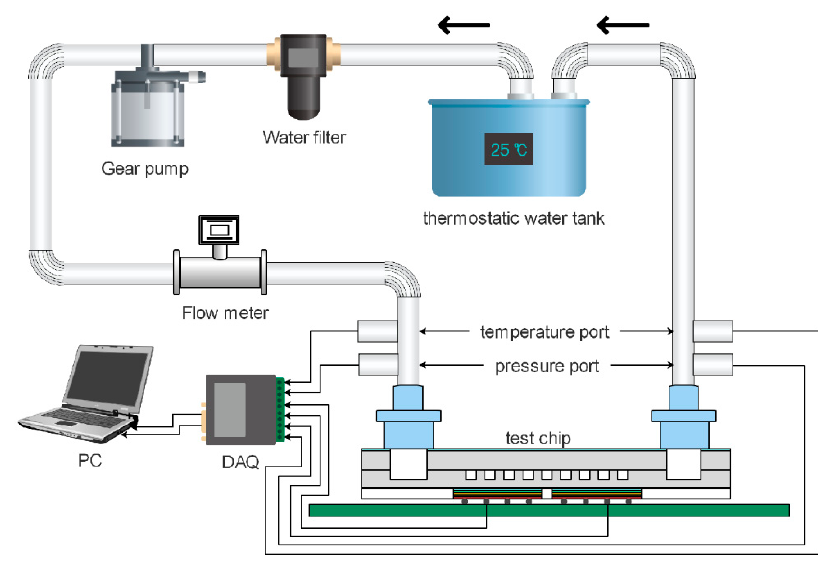
Figure 1. The experimental setup.